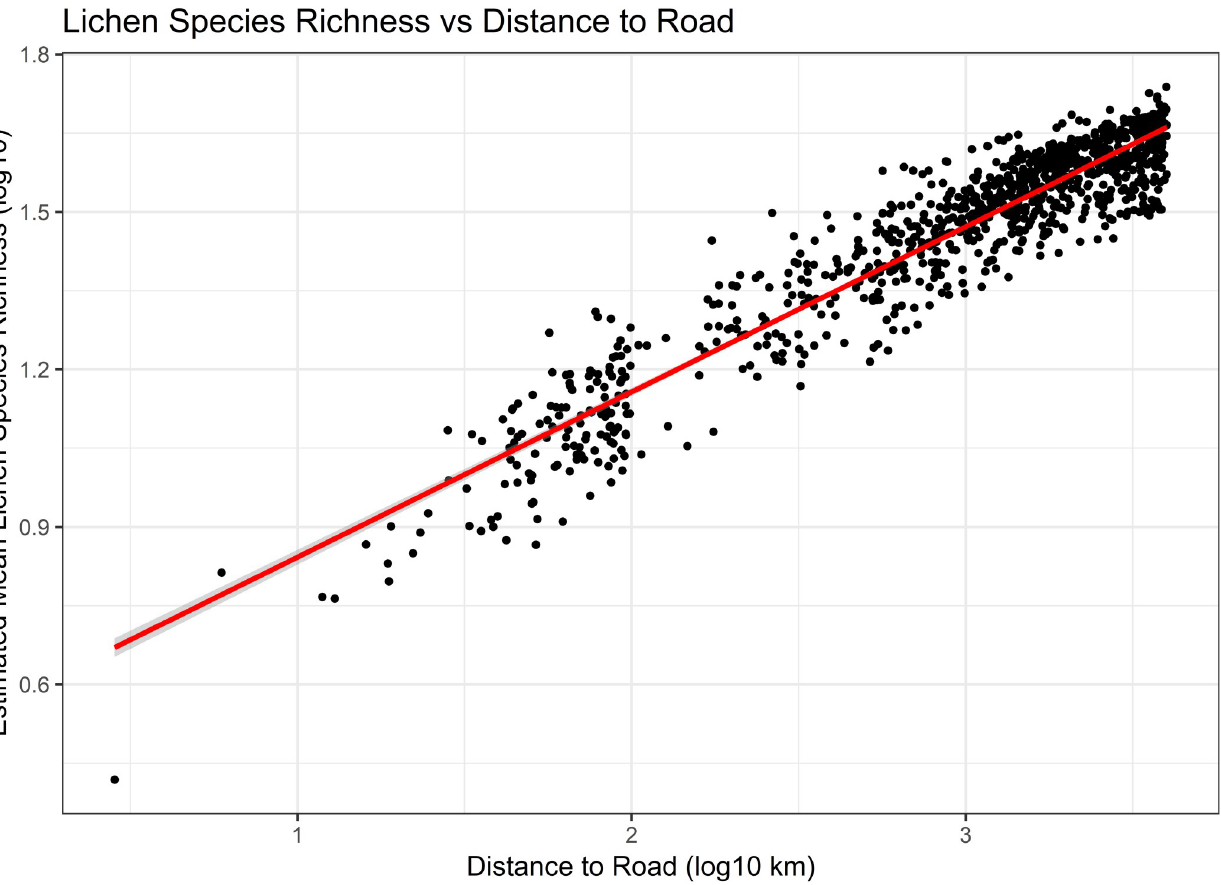
Fig 6. Estimated mean lichen species richness vs. distance to the DMTS haul road in Cape Krusenstern National Monument, Alaska, on a log-log scale from a Bayesian posterior predictions model. The 95% confidence interval is shown in grey.